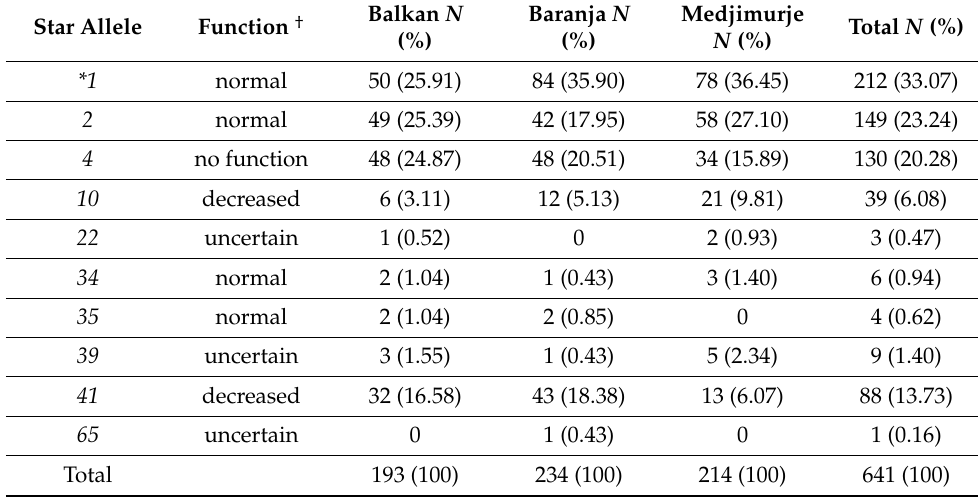
Table 3. Distribution of star alleles in the total Croatian Roma population and in the three subpopula- tions separately (Balkan, Baranja,